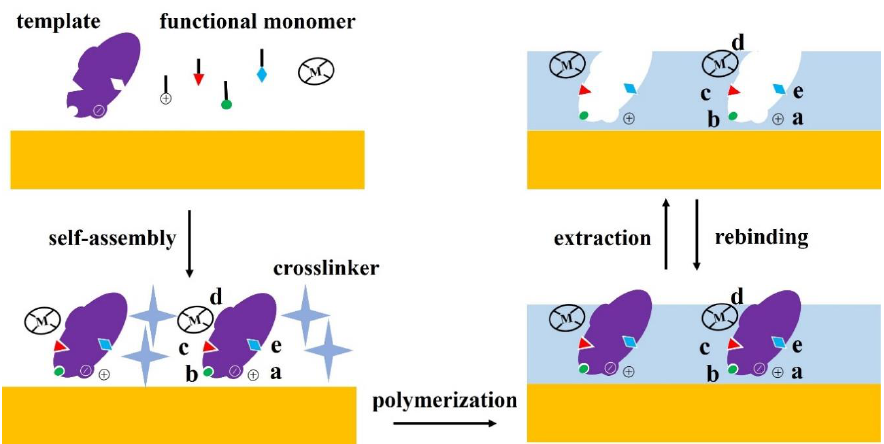
Figure 2. Preparation procedures of molecularly imprinted polymers (MIPs) and surface imprinted polymers (SIPs) on an electrode and various interactions of template (analyte) and MIPs/SIPs, ( a ) electrostatic interactions, ( b ) reversible covalent bonds, ( c ) van der Waals or hydrophobic interactions, ( d ) metal chelation, and ( e ) hydrogen bonds.